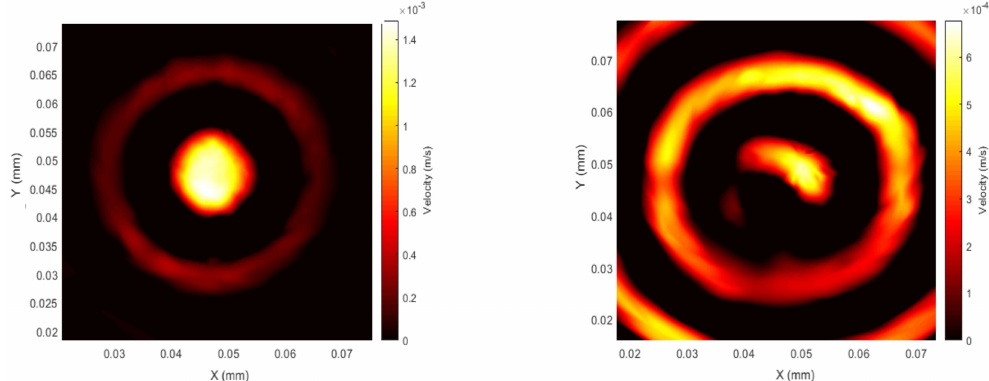
Figure 11. Configuration 3—patch spatial scan at the beginning of the first peak of the signal ( left , t = 14 µ s) and the end of the pulsed wave ( right , t = 22 µ s); f = 120 kHz, 1 cycle sine